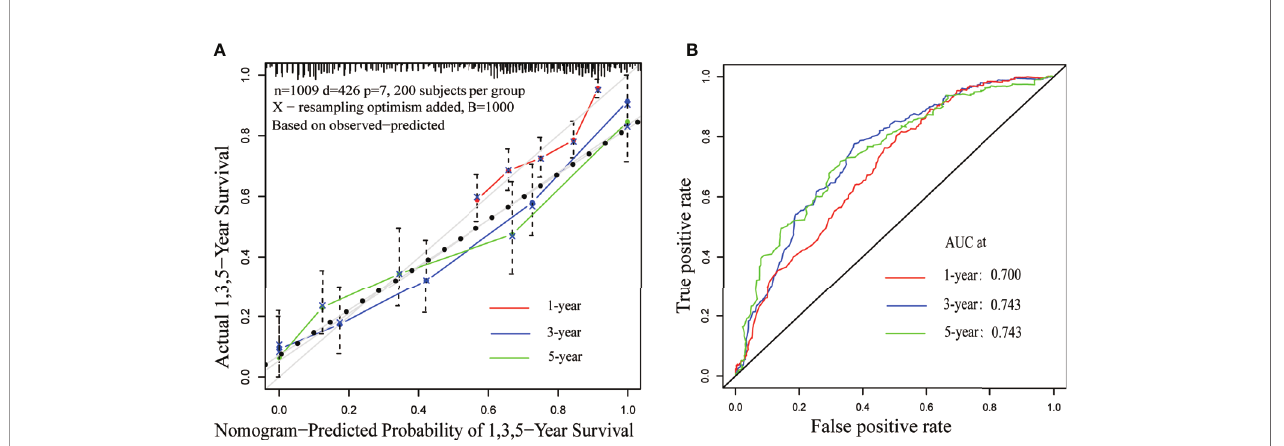
FIGURE 6 | Calibration and discrimination validation. (A) The calibration curve demonstrates the comparison of the survival prediction of the model to the actual observed survival. (B) Receiver operating characteristic (ROC) curve internally validates the model performance for discrimination.